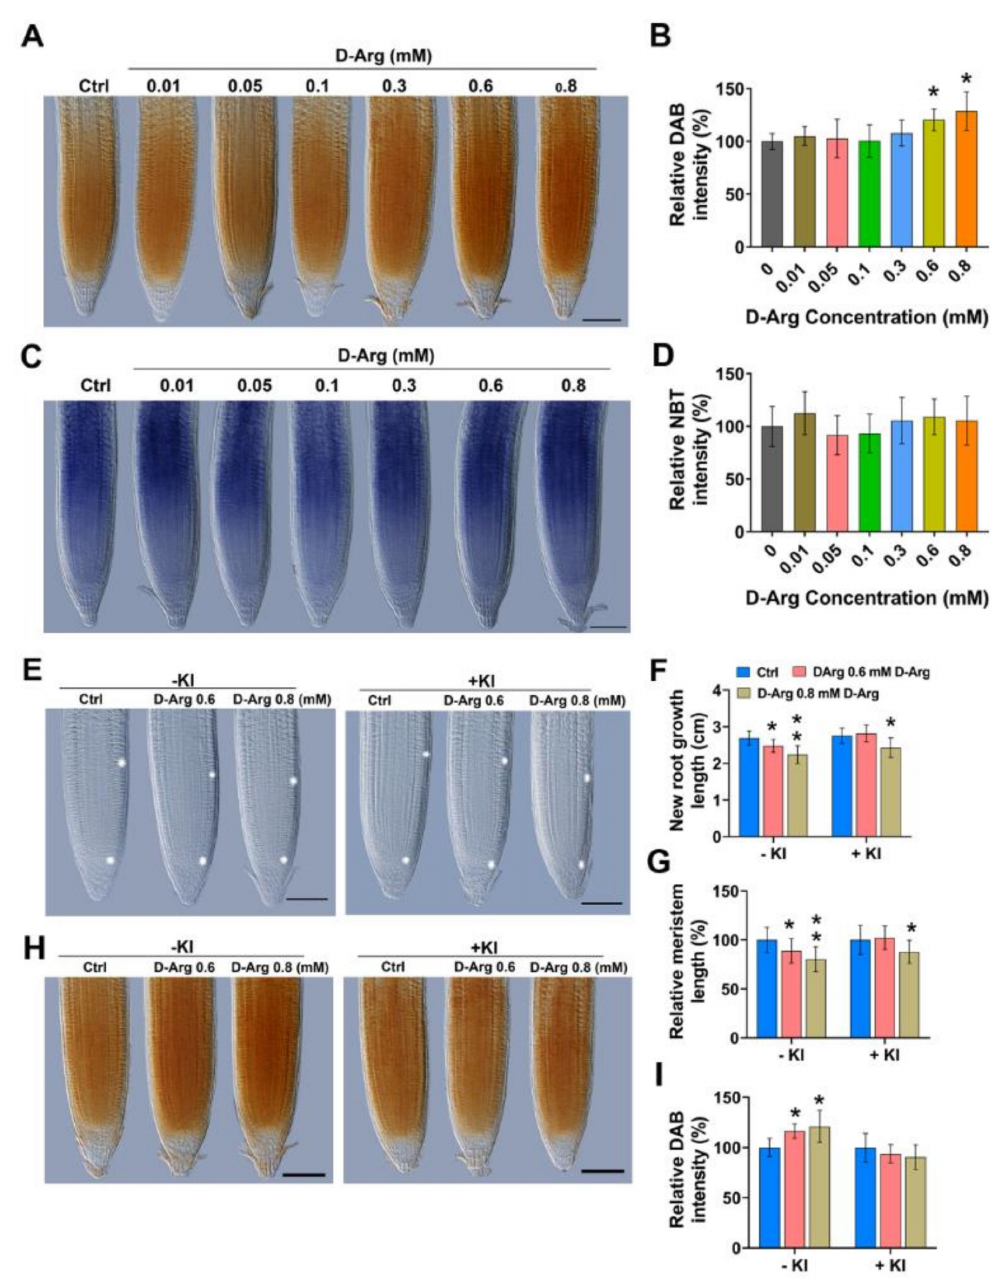
Figure 3. D-Arg-induced H 2 O 2 accumulation, root length, and MZ size reduction is partially rescued by ROS scavenging with 1 mM KI. Five-day-old seedlings at the same developmental stage were transferred to new media containing water (Ctrl) or D-Arg and treated for 3 days. MZ imaging by differential interference contrast (DIC) microscopy. ( A , B ) 3,3 (cid:48) - diaminobenzidine (DAB) staining and relative stain intensity indicate that D-Arg treatment increases H 2 O 2 accumulation in root meristem. ( C , D ) Nitrotetrazolium blue (NBT) staining and relative stain intensity indicates that D-Arg treatment does not change O 2 − accumulation in the root meristem. ( E – G ) Treatment with and without D-Arg and 1 mM KI shows partial rescue of root meristem and root length by KI. ( H , I ) DAB staining of root meristem and relative stain intensity, with or without D-Arg and KI, show successful H 2 O 2 scavenging by KI. All scale bars = 100 µ m. Data shown are averages ± SD (n > 30). Asterisks indicate significant differences compared with the control (* p < 0.05, ** p < 0.01; Student’s t